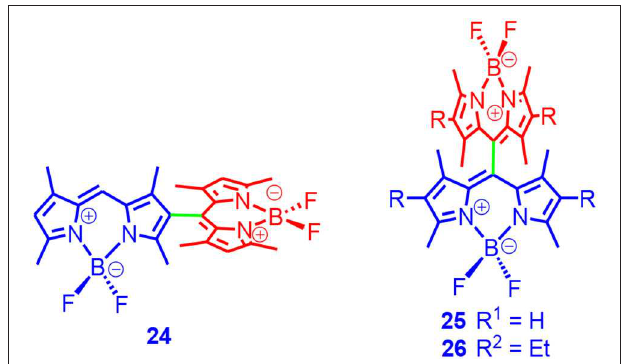
FIGURE 7 | Orthogonal Bodipy dimers showing efficient